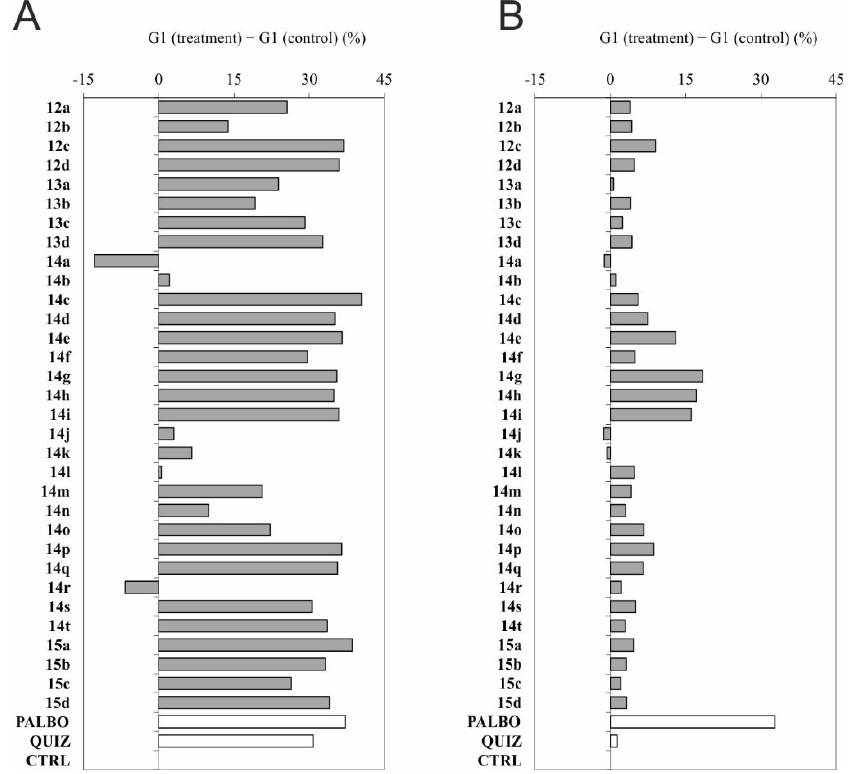
Figure 4. Cell cycle G1 phase population upon treatment of MV4-11 ( A ) and K562 ( B ) cells with a 200 nM concentration for 24 h. Data (in %) are expressed as differences between G1 populations in treated and control cells. PALBO, palbociclib; QUIZ, quizartinib.